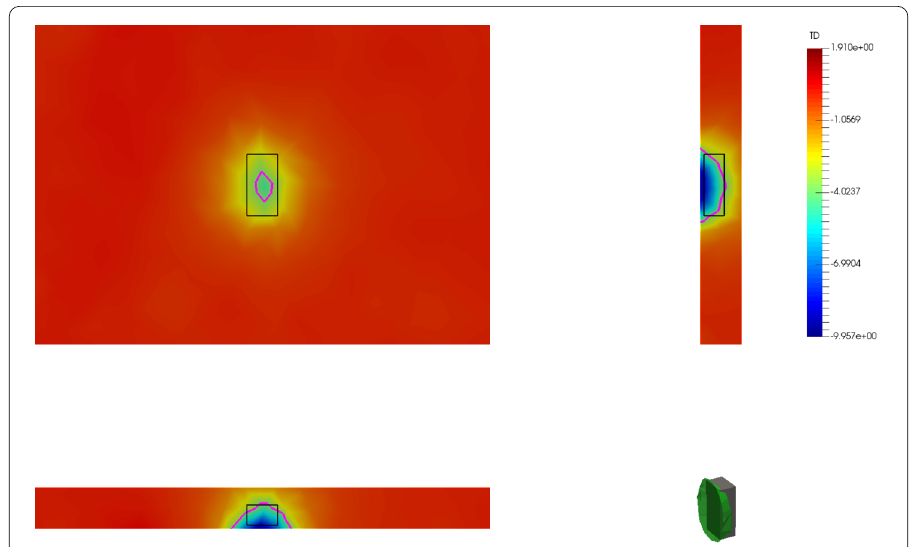
Figure 16 Reconstruction of the box-shaped defect. Upper left: Topological derivative at x = 0. Upper right: Topological derivative at y = –0.125. Lower left: Topological derivative at z = 0.25. Lower right: Perspective showing the reconstruction for λ = 0.4 and the original